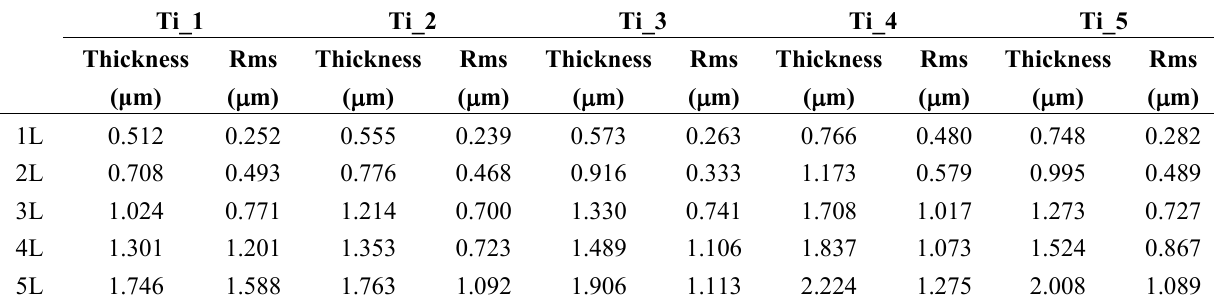
Table 2. Thickness and roughness of printed samples.